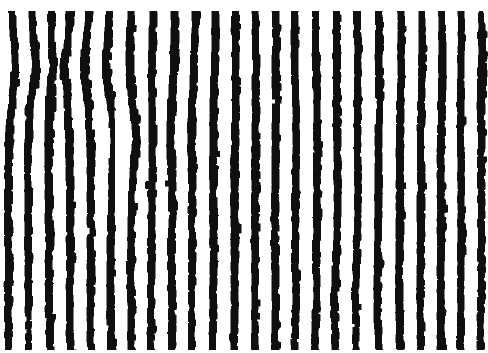
Figure 10: Elaboration of Figure 7 aimed to highlight the spatial in- formation (two-level binary image) of the vertical lines.